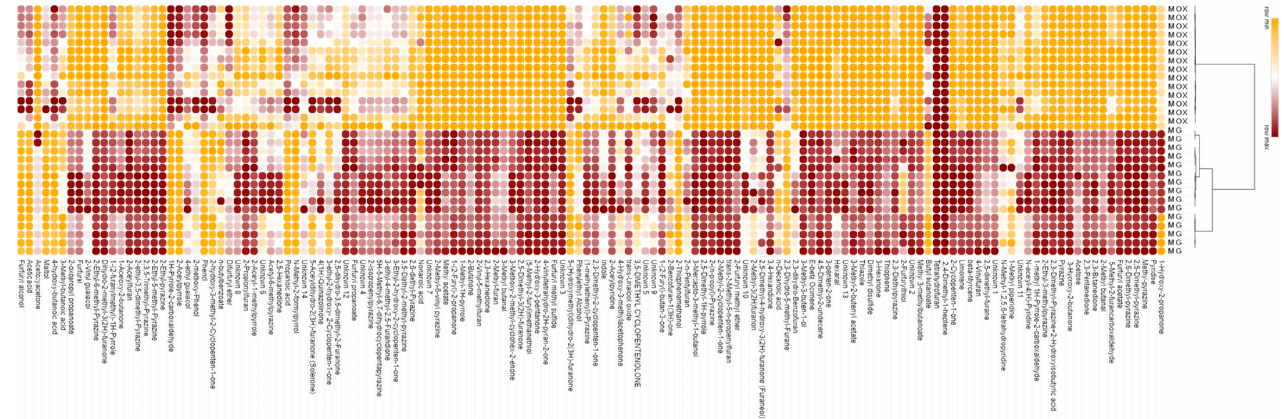
Figure 1. Heat map of the chemical normalized IS fingerprints of the good and oxidised moka samples (M). Samples are clustered using ascendant hierarchical clustering based on Euclidean distances using the average linkage agglomerative method. MG (moka good coffee) and MOX (moka oxidised coffees).